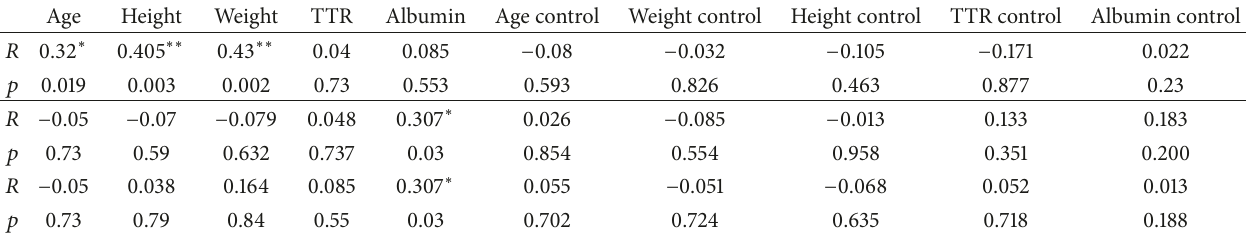
Table 4: Gender adjusted Pearson correlation coefficients between anthropometric and biochemical indices for malnourished